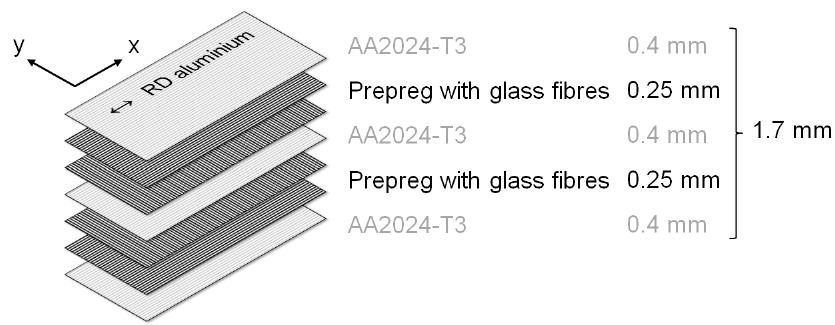
Figure 1. Layup of aluminium alloy 2024-fibre metal laminate (AA2024-FML) 3-3/2-0.4 mm.